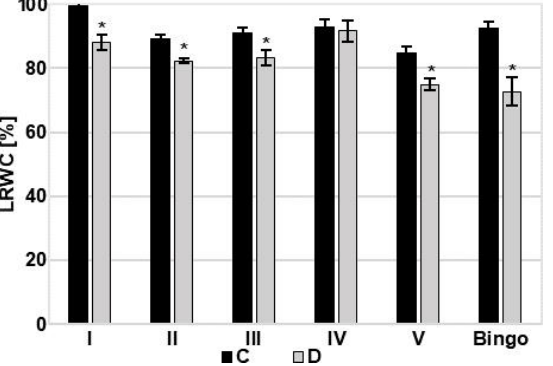
Figure 5. Leaf relative water content (LRWC) [%] of OMA lines and cv. Bingo on the 14th day of drought. C—control, 70% FWC, black bars; D—drought, 25% FWC, grey bars. The mean values (n = 5) ± SE marked with an asterisk (*) are significantly different at p ≤ 0.05 according to the Student’s t test.